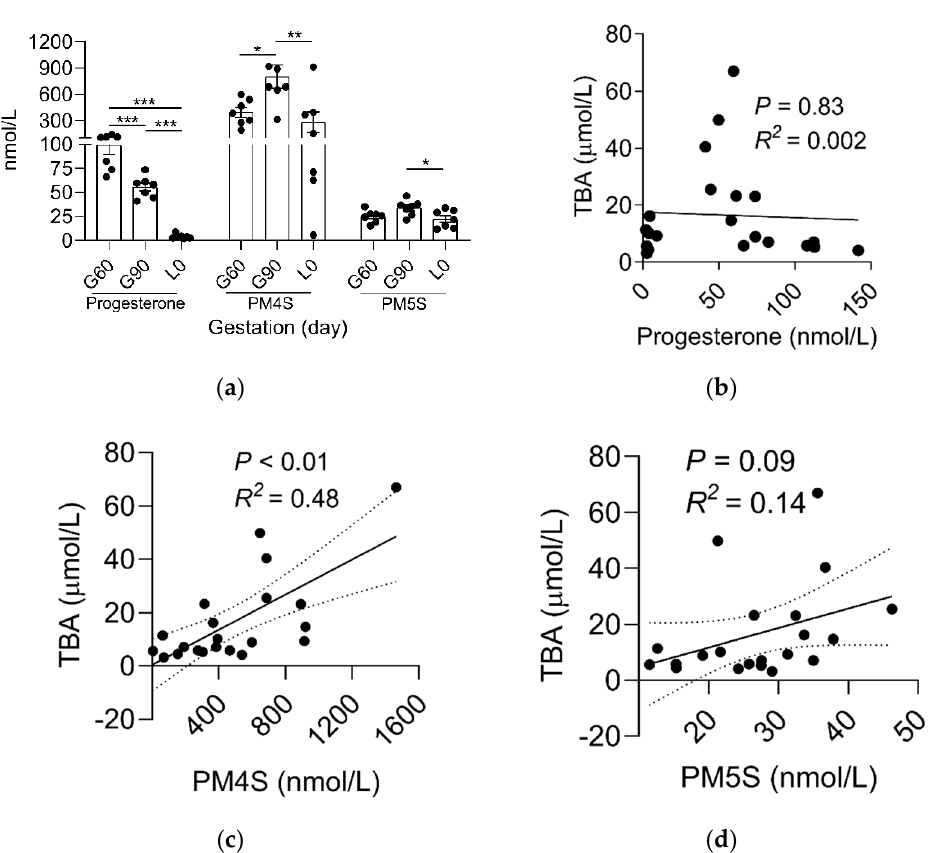
Figure 2. The comparison of maternal serum ( a ) progesterone, PM4S, and PM5S at G60, G90, and L0. n = 7/group. The linear correlation of ( b ) progesterone, ( c ) PM4S, and ( d ) PM5S and maternal serum TBA. n = 21. Data are shown as means ± SE, * p < 0.05, ** p < 0.01, *** p < 0.001.